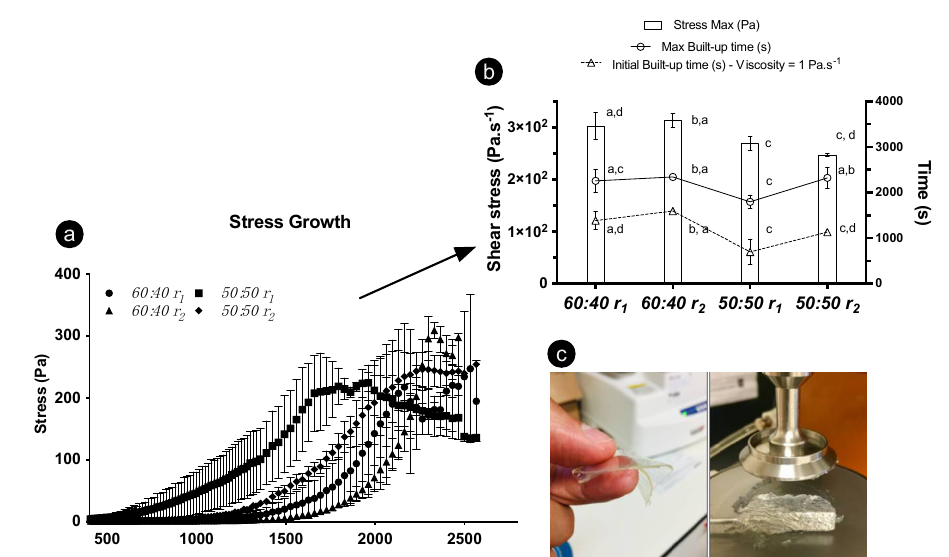
Figure 7. Rheological results for 8 wt% oleogels; γ-oryzanol-β-sitosterol with 50:50 and 60:40 ratios were tested. ( a ) Stress growth curves; ( b ) stress max, max build-up, and initial build-up data gathered after using different cooling ramps (r1 = 1 ◦ C · min − 1 and r2 = 7 ◦ C · min − 1 ); ( c ) gels obtained through rheology.